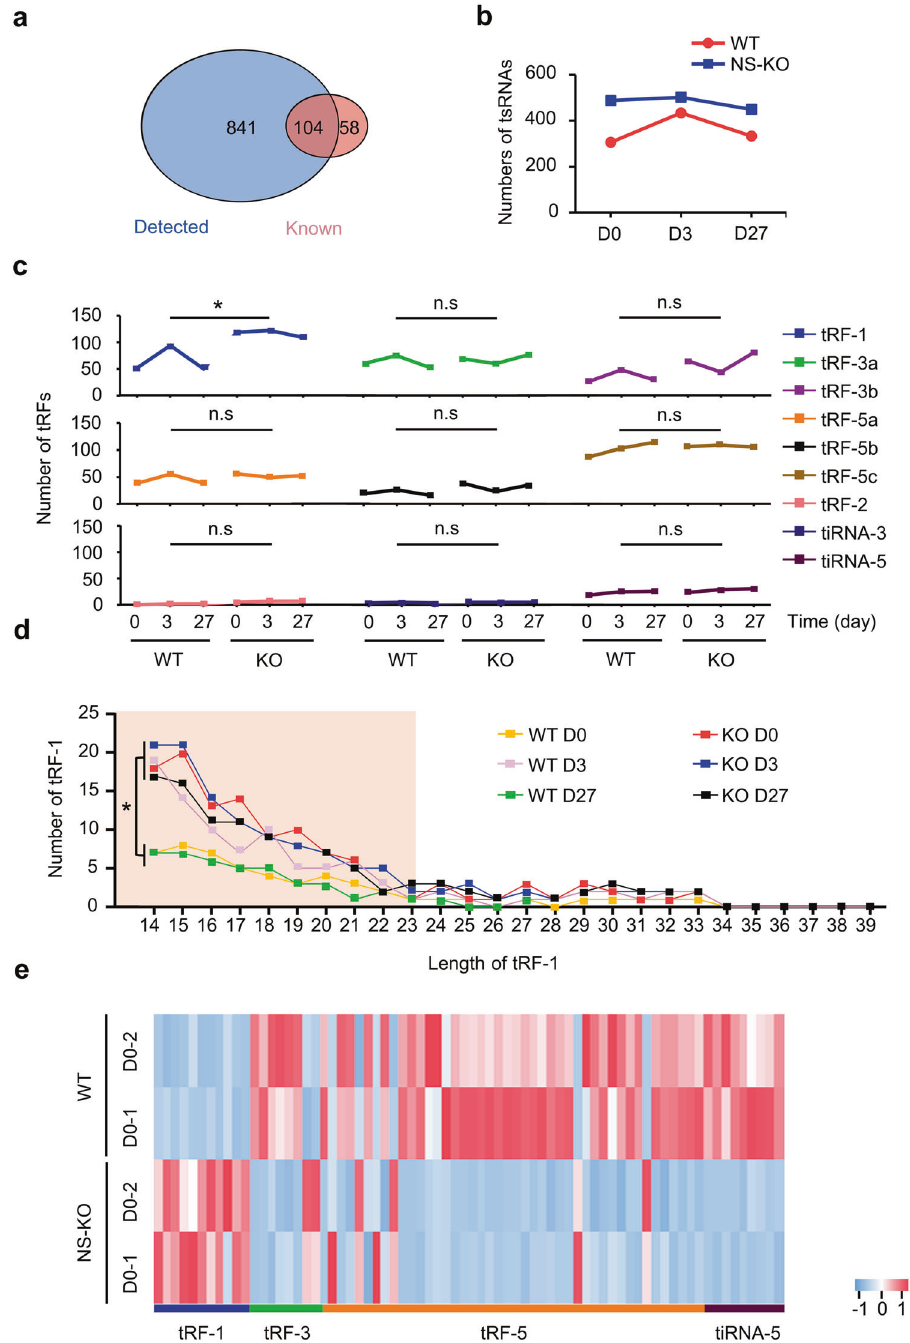
Fig. 4 tsRNA-seq showing the signature of tRF-1s in WT and NS-KO mice subjected to stress. a Venn diagram showing the known tsRNAs from tRFdb 20 and the tsRNAs detected from tsRNA-seq. b Group line chart showing the different number of tsRNAs at different time points in WT and NS-KO mice. D0: day 0: no injury; D3: day 3 after injury; D27: day 27 after injury. n = 2 mice. c Group line chart showing the distribution of subtypes of tsRNAs. The Y-axis represents the number of tsRNAs subtypes. The X-axis represents the injury time points in WT and NS-KO mice. d The number of tRF-1s against the length of tRF-1s reads. A line chart showing the sequence read length distribution in WT and NS-KO mice at different injury time points. The X-axis represents the length of tRF-1s, and the Y-axis represents the number of tRF-1s. The color represents the injury time points in WT and NS-KO mice. e Hierarchical clustering heatmap of differentially expressed tsRNAs ( P < 0.05 and log 2 FC > 2). Each column represents each tsRNA, and all selected tsRNAs are categorized into no more than six clusters based on the tsRNAs subtypes. Each row represents a replicate. The color in the panel represents the relative expression level of the same type of tsRNAs (row normalization by z-score). The color scale is shown on the right: blue represents an expression level below the mean; while red represents an expression level above the mean. All data in this fi gure are acquired by tsRNA-seq, with two duplicates performed for each group. All data are expressed as the mean ± SD. * P < 0.05, n.s no signi fi cance, Student ’ s t -test